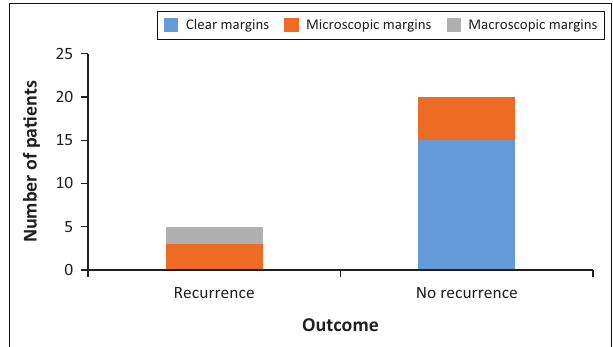
FIGURE 4: Surgical margins and recurrence